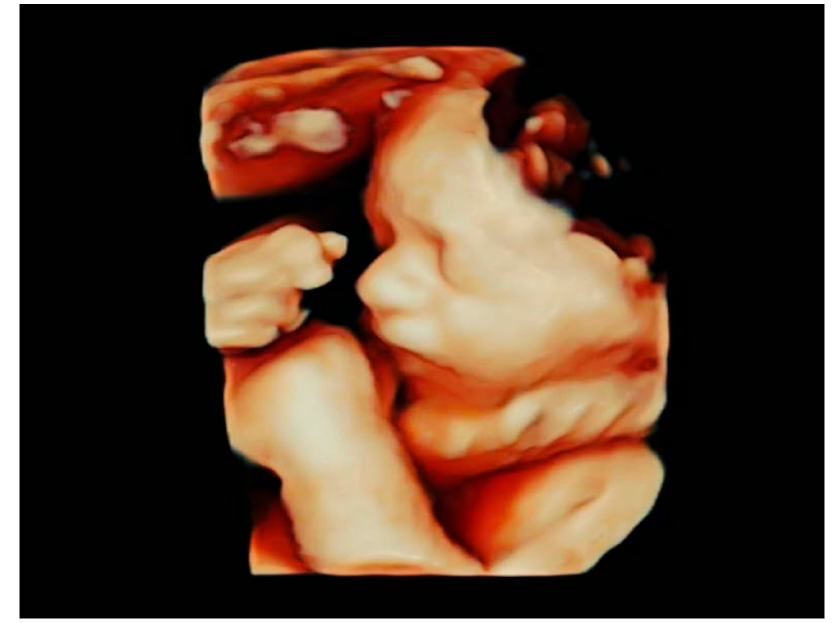
Figure 1. Three ‐ dimensional image showing a nuchal cord. Figure 1. Three-dimensional image showing a nuchal